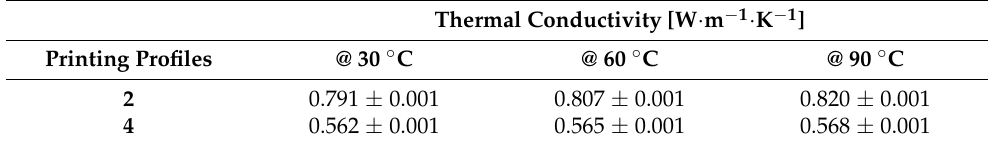
Table 16. Thermal conductivity values of the green parts for three values of observed